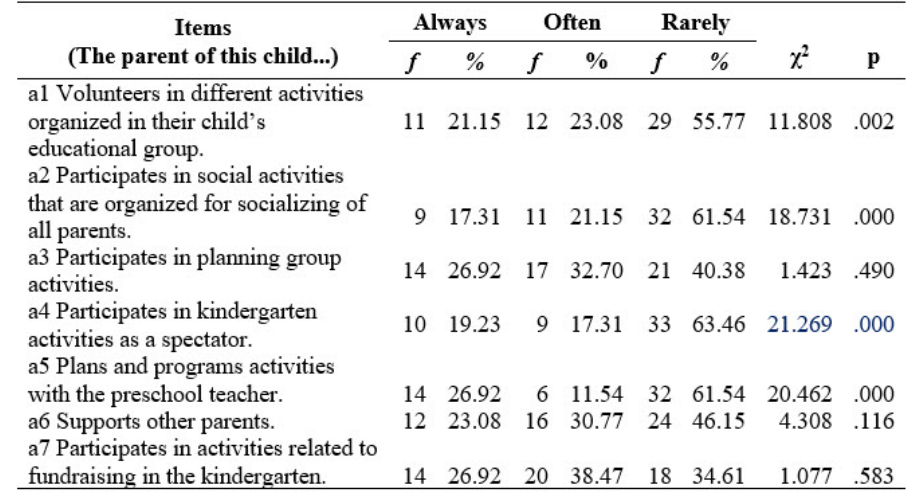
Parents involvement in kindergarten activities within the integrated approach to learning from the point of view of preschool